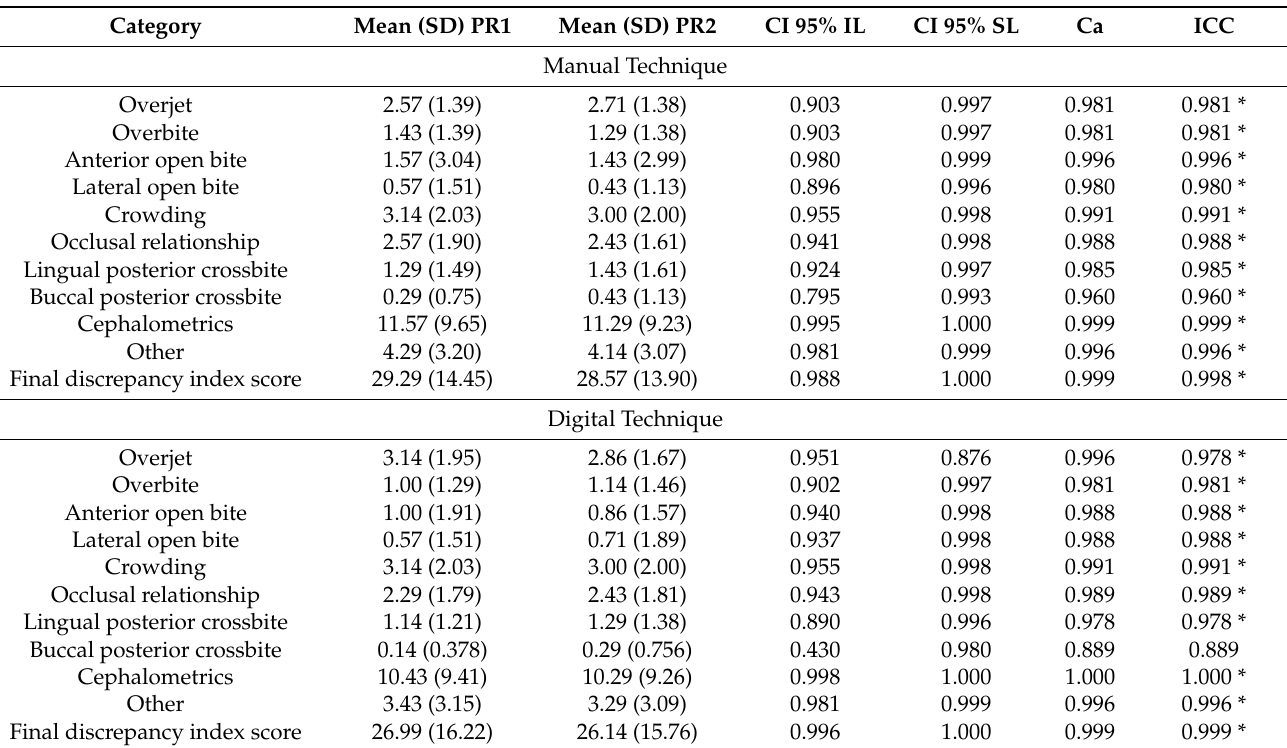
Table 2. Intrarater reliability